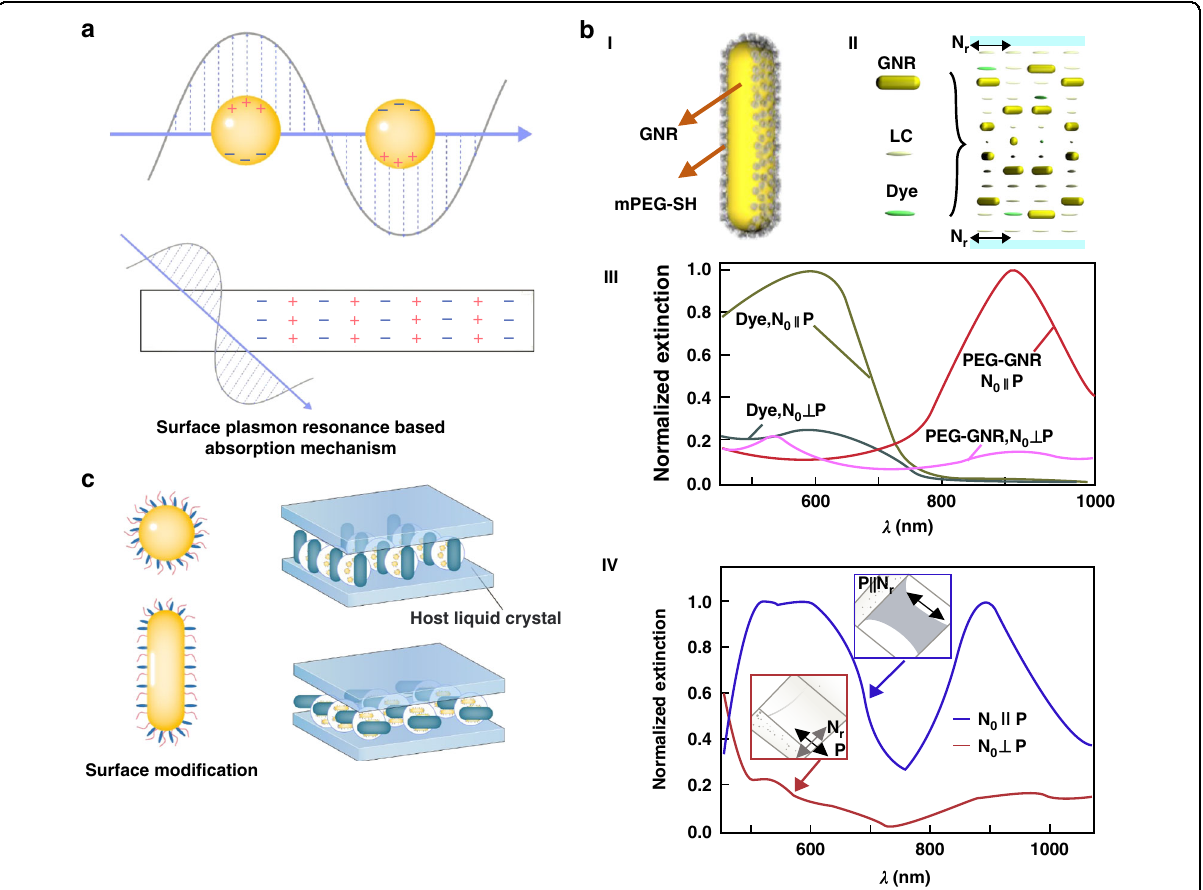
Fig. 7 Switchable optical devices doped with nanoparticles. a Absorption mechanism of surface plasmon resonance. b Through surface modi fi cation, the alignment of gold nanorods and liquid crystals was induced to achieve broadband absorption modulation: (I) surface modi fi cation of GNRs, (II) gold nanorods and dichroic dyes aligned with liquid crystals, (III) gold nanorods and dichroism absorption spectra of dyes, and (IV) absorption spectra of liquid crystal devices codoped with gold nanorods and dichroic dyes. Reproduced with permission from ref. 103 . Copyright 2018, Optica Publishing Group. c Surface modi fi cation of nanoparticles with different shapes and their applications in LC